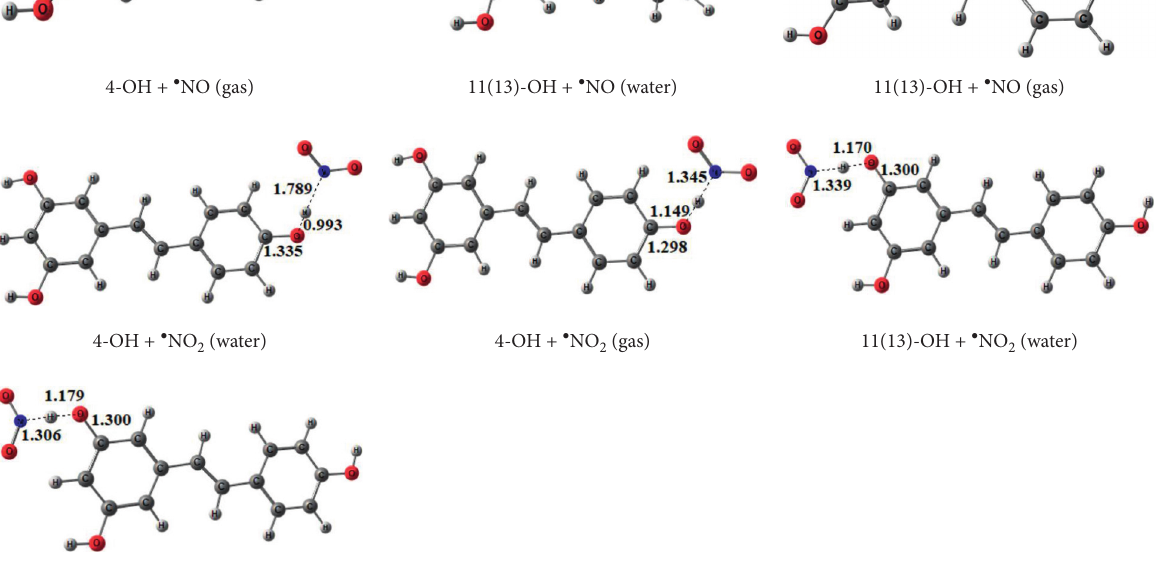
Figure 9: The optimized structures of TSs when • HOO, CH3O • , • NO, and • NO 311++G(d, p) level of